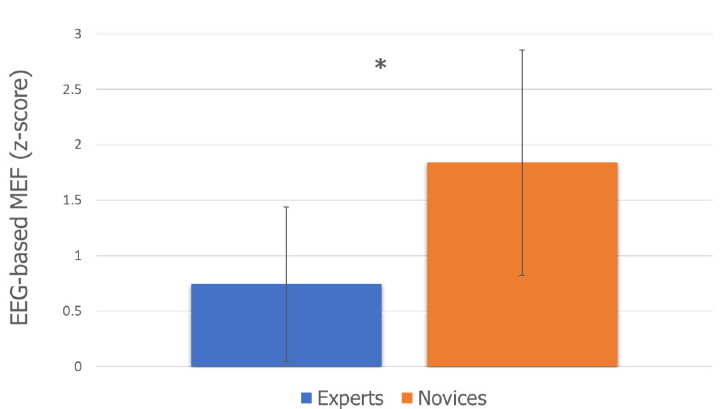
Figure 6. Median MEF index of the Experts (blue bar) and Novices (orange bar) estimated from their brain activity across the different flight phases. Significant difference ( p = 0.035) was found between the two groups. The asterisk means that the differences were statistically significant ( p < 0.05).